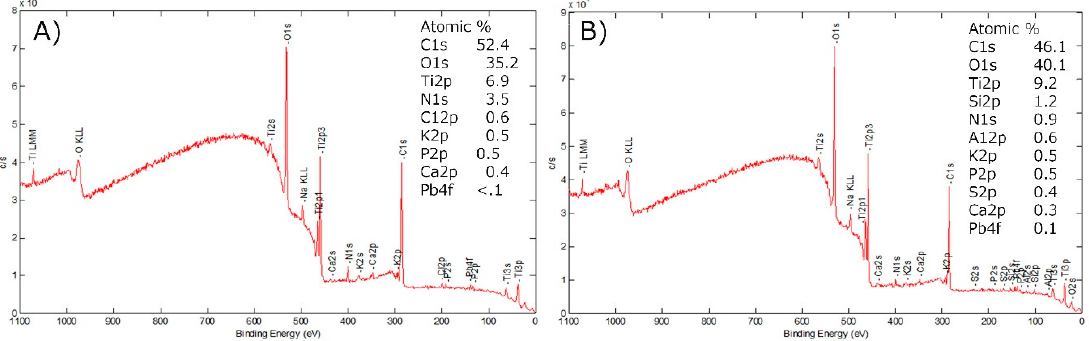
Figure 2. X-ray photoelectron spectroscopy (XPS) analysis of the treated titanium disks. The XPS survey spectrum shows the atomic ratio of each treated disk. ( A ) Control disks (Ctrl-Ti condition), subjected only to autoclaving. ( B ) Disks treated with low-temperature plasma (LTP; LTP-Ti condition) after autoclaving.